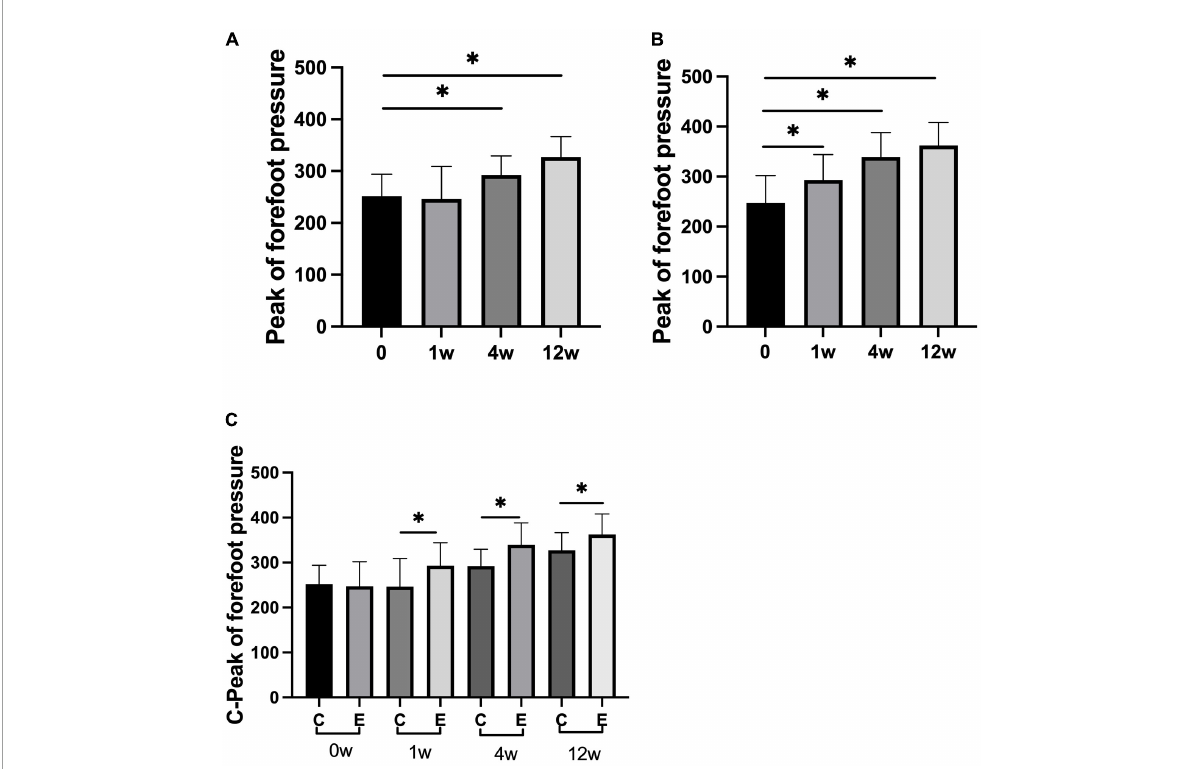
FIGURE7 Changes in peak of forefoot pressure ( N ). (A) Forefoot pressure in control group at 1, 4, and 12 weeks compared with that at 0 week; (B) forefoot pressure at 1, 4, and 12 weeks compared with that at 0 week in experimental group; (C) forefoot pressure at 0, 1, 4, and 12 weeks in experimental group compared with control group; ∗ p <